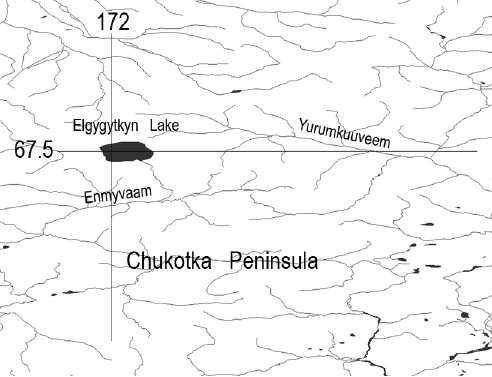
Fig. 25. Map of Elgygytkyn Lake Area, Upper Yurumkuuveem and Enmyvaam Rivers calving